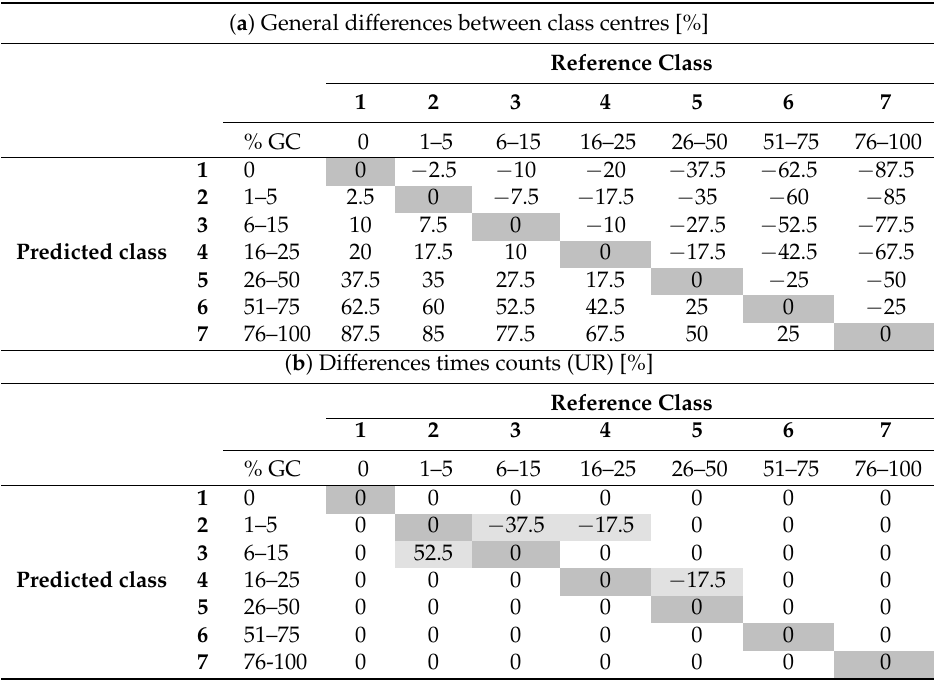
Table 3. Matrices describing the accuracy assessment results by using the differences between the percentage values at the class centres. Subtable ( a ) gives an overview of the general differences between percentage values at the class centres for all class combinations. In subtable ( b ) the percentage difference between each class combination was multiplied by the related count in the confusion matrix of Table 2a. Subtable ( c ) shows for the same for the established regeneration and uses the confusion matrix in Table 2b. In subtable ( d ) the differences from subtable ( b ) have been scaled with their L1-norm. Subtable ( e ) scales the respective differences for the established regeneration. UR = unestablished regeneration, ER = established regeneration, GC = ground